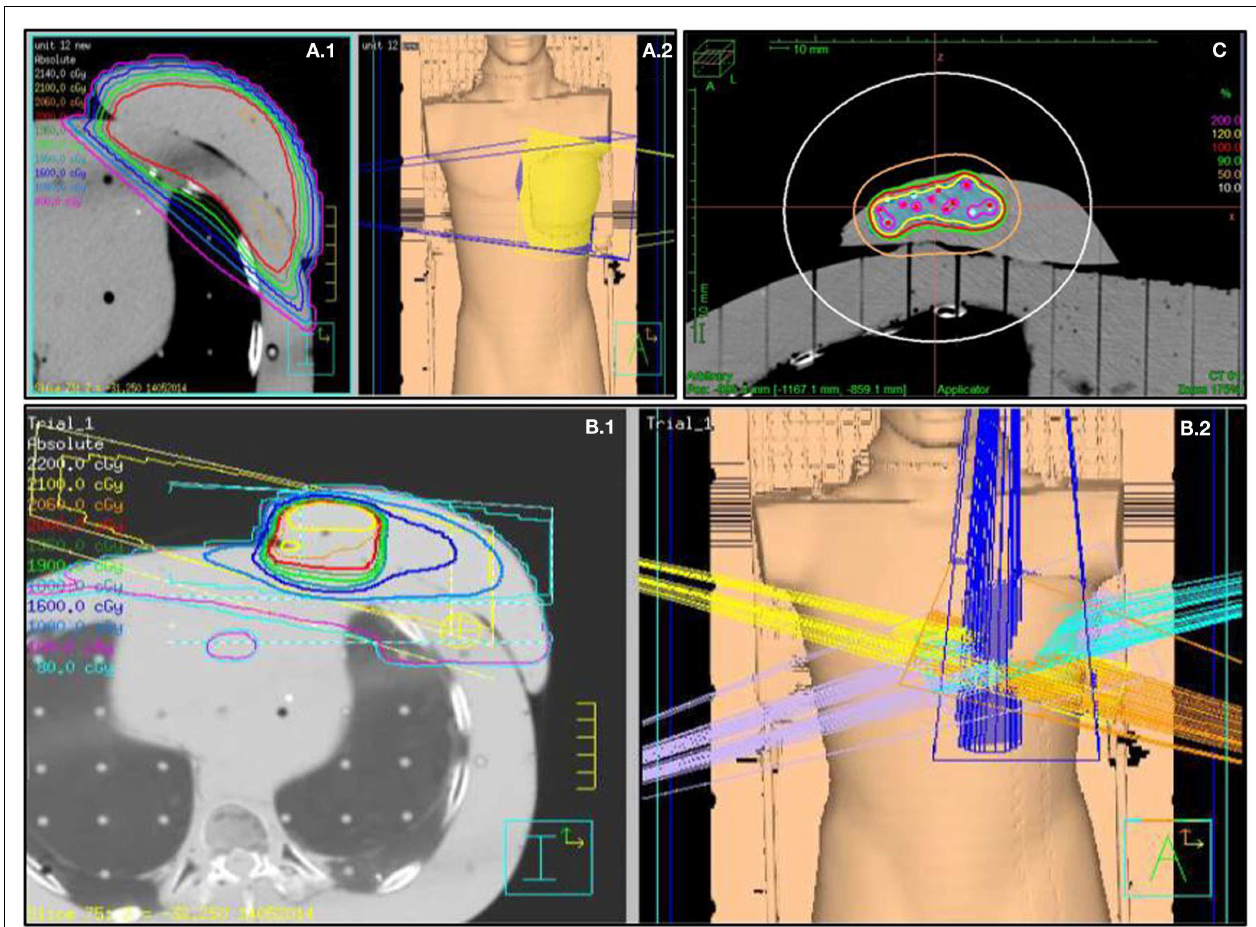
FIGURE 2 | Fields arrangement and various breast treatments dosimetry . (A.1) Medium sizeWBI treatment dosimetry and (A.2) tangential fields 3D representation. (B.1) 3D-CRT APBI dosimetry and (B.2) five fields no coplanar 3D representation. (C) Multicatheter HDR APBI